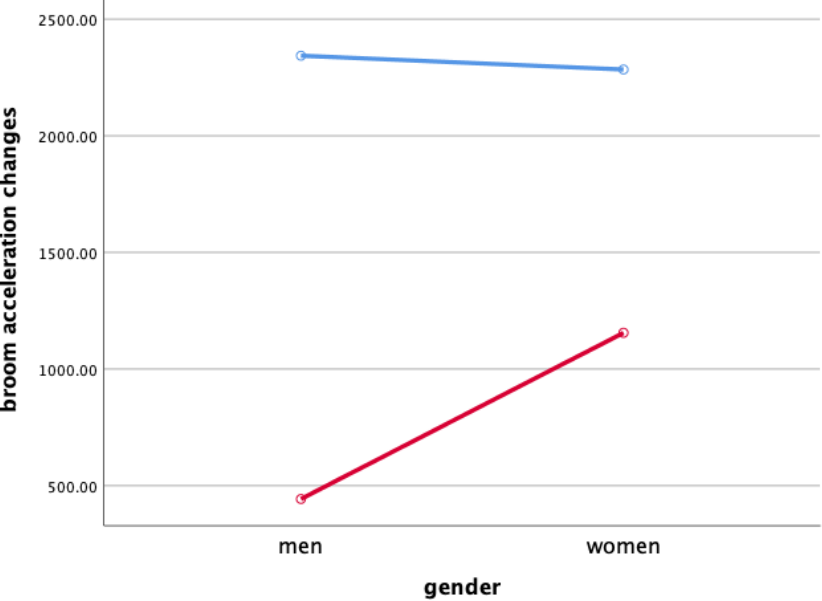
Figure 7. Broom Acceleration Changes When Sweeping(Y)—main effect (mG). Red line: along the axis of motion, blue line: perpendicular to the axis of motion.